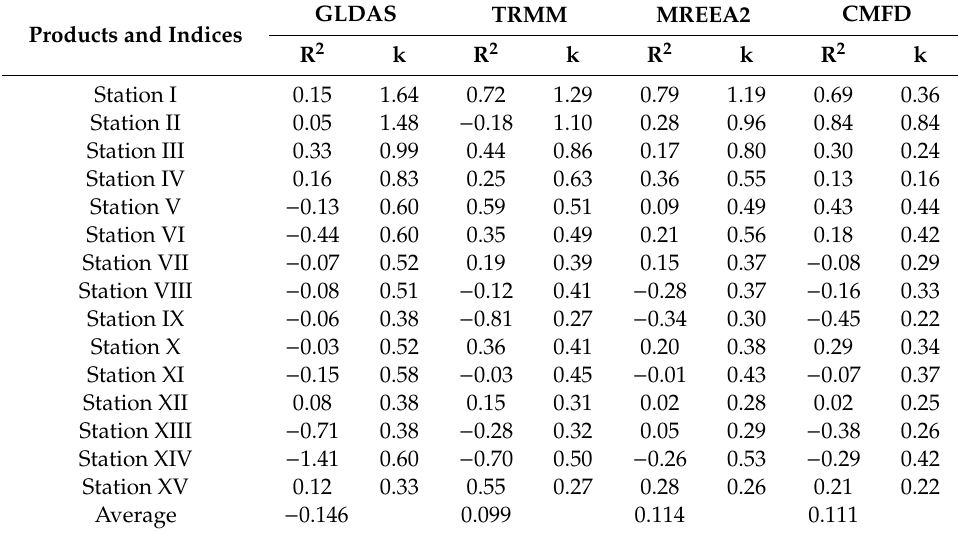
Table 1. The R 2 and proportionality coe ffi cient (k) of monthly precipitation in each product over all